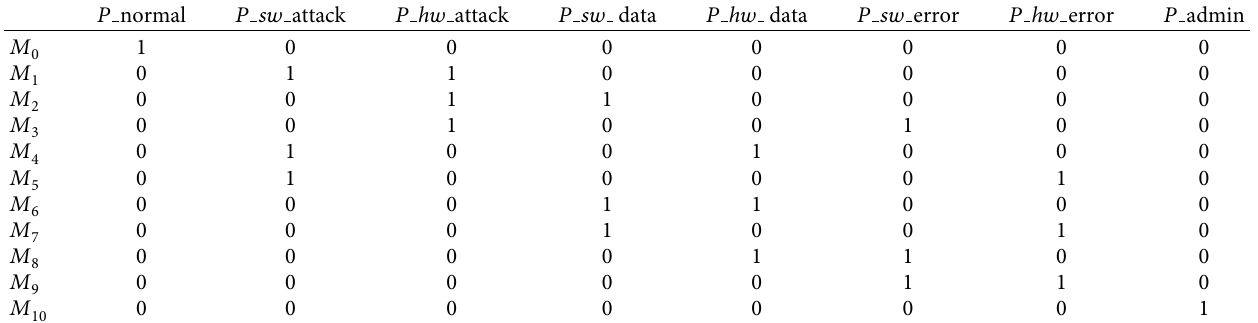
Table 4: Reachable marking set of the SPN model.